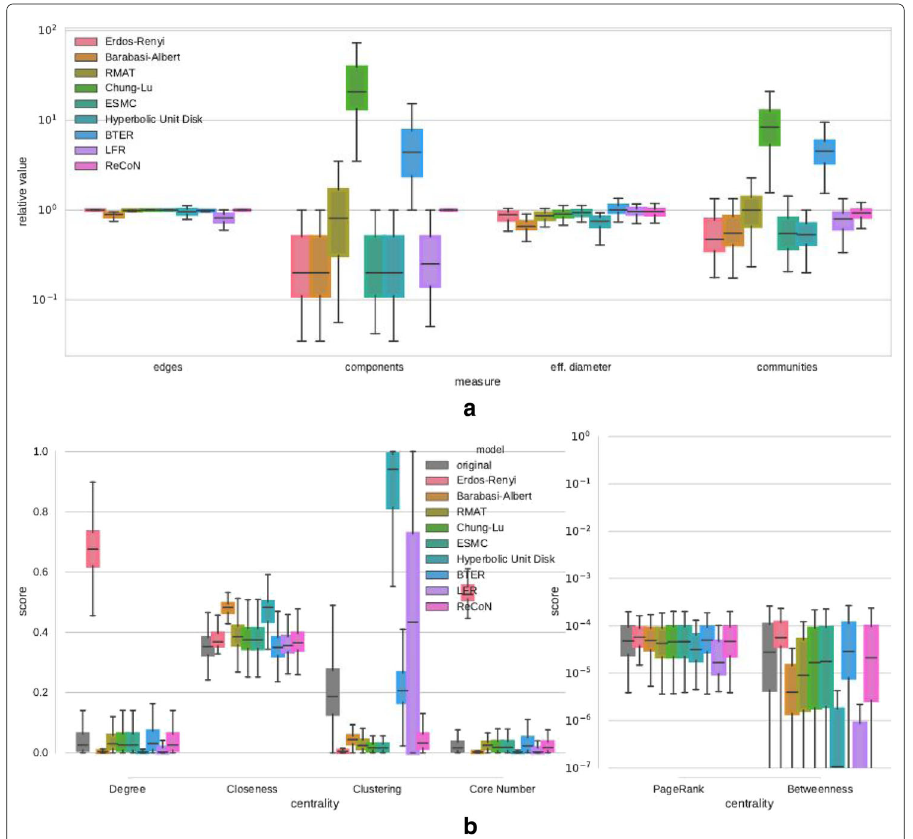
Fig. 9 StructurereplicationofFacebooknetworks a Relative deviation ofscalar network properties, b Distribution of centrality scores